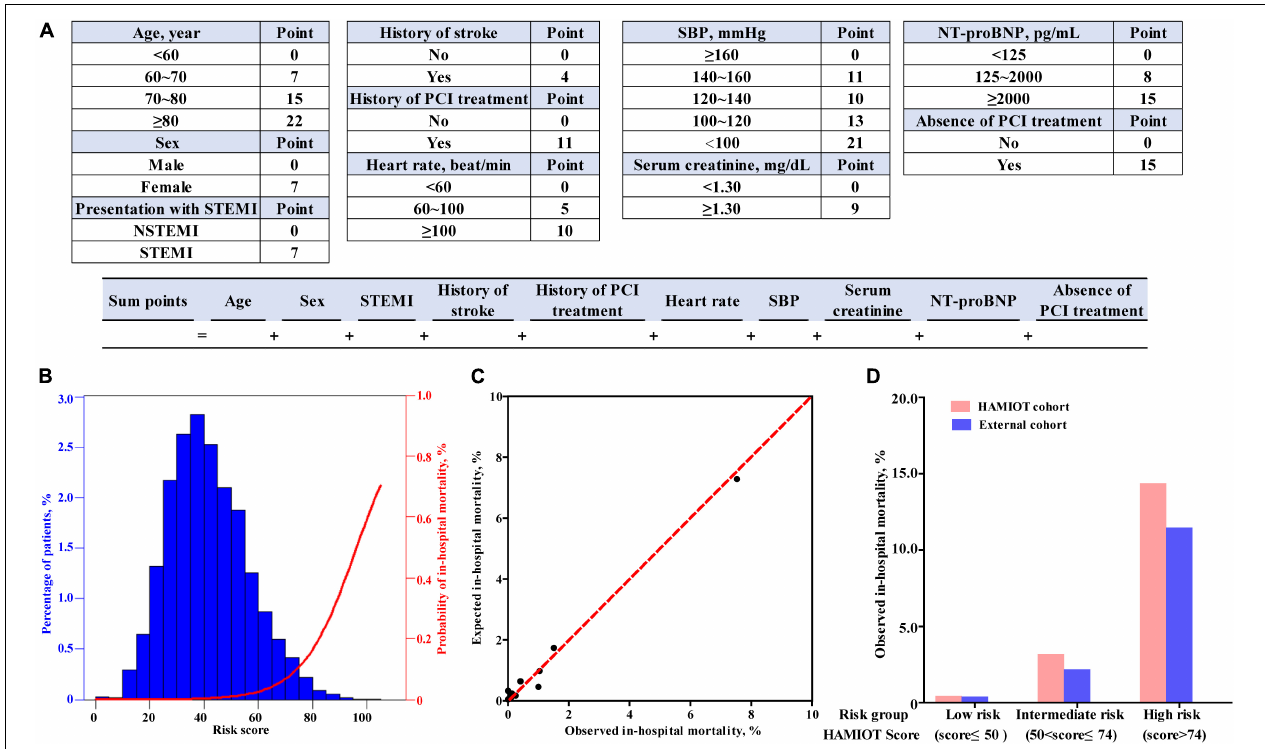
FIGURE 3 | (A) Risk score calculator of in-hospital mortality for patients with AMI. (B) Distribution of HAMIOT risk score and the probability of in-hospital mortality. (C) Relationship between the observed and expected in-hospital mortality across deciles of risk. (D) Observed in-hospital mortality of HAMIOT cohort and external cohort stratified by three risk groups (low risk, intermediate risk, and high risk groups). The observed in-hospital mortality rates were 0.35, 3.09, and 14.29% in the HAMIOT cohort, and 0.31, 2.21, and 11.39% in the external cohort, respectively. HAMIOT, the Heart failure after Acute Myocardial Infarction with Optimal Treatment, STEMI, ST-segment elevation myocardial infarction; NSTEMI, non-ST-segment elevation myocardial infarction; SBP, systolic blood pressure; NT-proBNP, N-terminal pro-B-type natriuretic peptide; PCI, percutaneous coronary